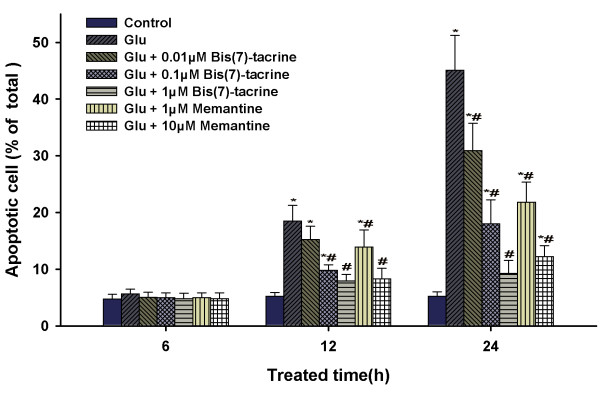
Bis(7)-tacrine reduces glutamate(Glu)-induced apoptosis of RGCs in vitro. RGCs were cultured with and without glutamate for 6-24 h in the presence or absence of bis(7)-tacrine (0.01-1 μM) or memantine (1-10 μM). Percentage of apopotic cells was detected by Annexin-V FITC/PI staining by flow cytometry. Apoptotic cells included Annexin V(+)/PI(-) and Annexin V(+)/PI(+) cells. Results were expressed as the means ± SEM of 7 independent experiments. (*P < 0.05 as compared to the control group for each time point; # P < 0.05 as compared to the glutamate group for each time point).